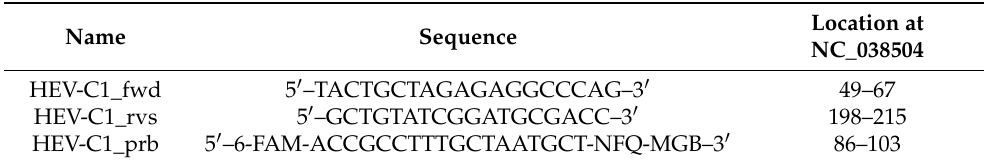
Table 1. Primers and probe sequences used for Orthohepevirus C genotype 1 (HEV-C1, rat HEV) RT-qPCR detection.